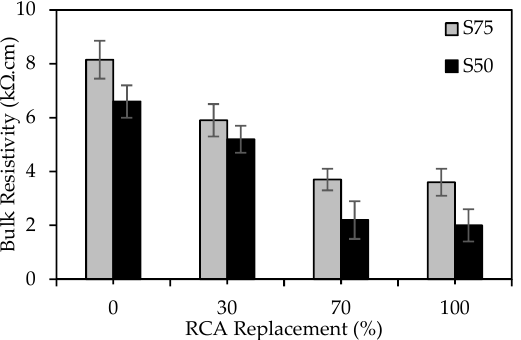
Figure 20. Bulk resistivity of alkali-activated slag concrete as a function of RCA replacement.